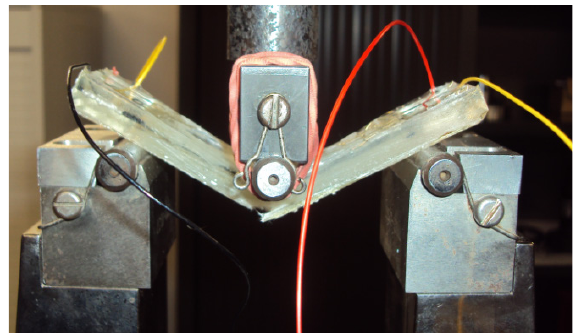
Figure 10. Glass laminate composite specimen with embedded sensors, loaded on an Instron 1185 tester for a 3-point bending